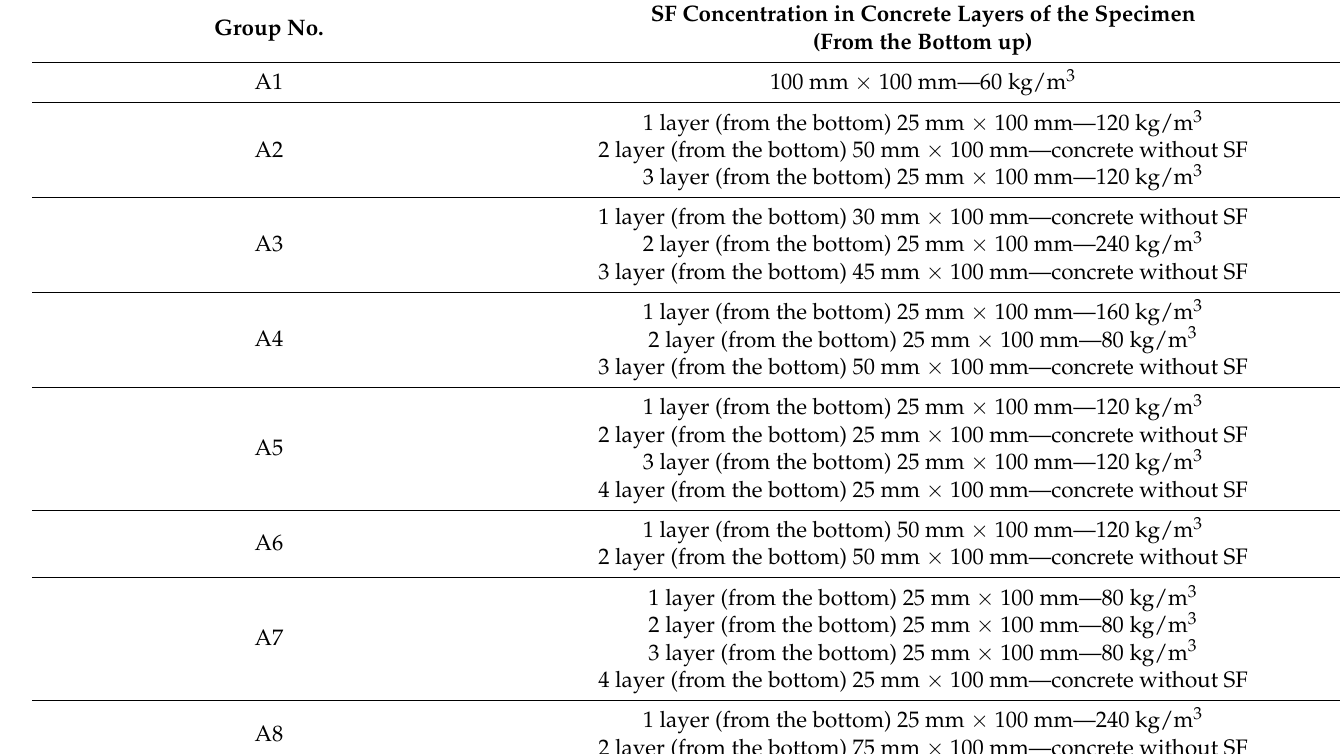
Table 3. SF distribution and concentration in the SFRC layer kg/m 3